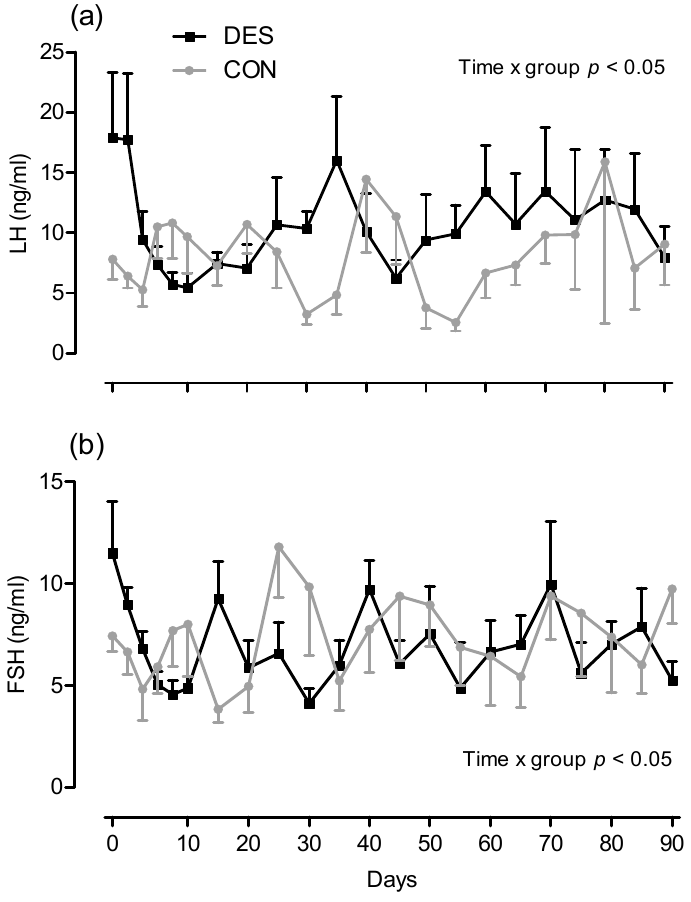
Figure 2. Mean plasma LH ( a ) and FSH ( b ) concentration (ng/mL) in mares of experimental groups DES (9.4 mg slow-release deslorelin; black squares, n = 6), and CON (1.25 mg short-acting deslorelin, grey circles, n = 6). Information on statistical analysis is given in the figure.